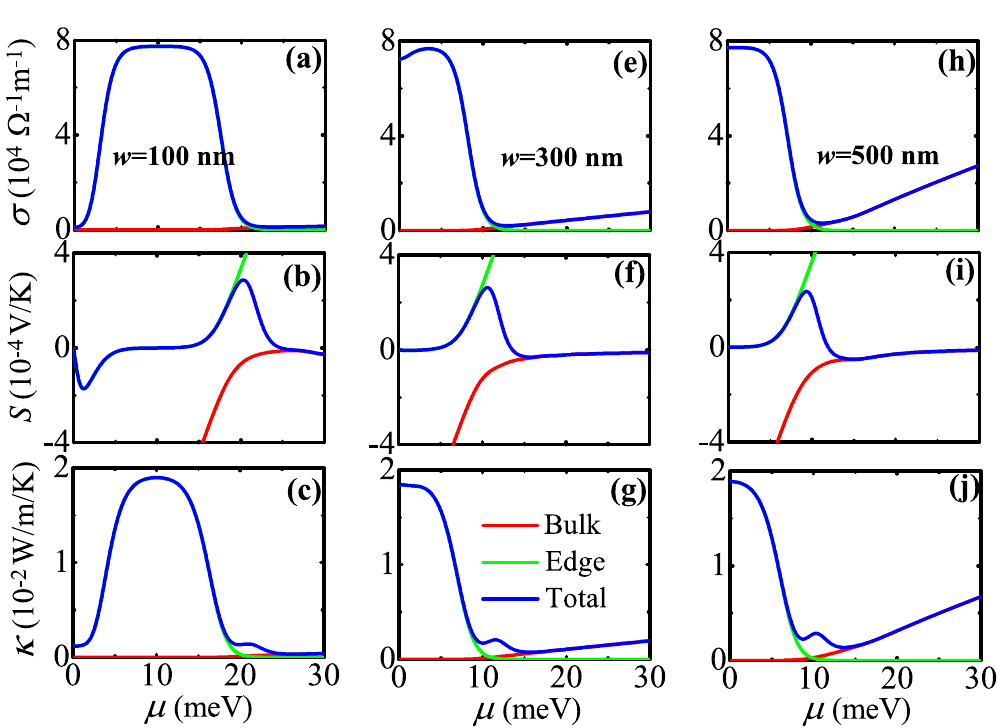
Figure 6. Electric conductivity, Seebeck coefficients, and electron thermal conductivity as a function of the chemical potential for various temperature-driven 2D TIs with different ribbon widths, where ( a )~( c ) plot the results for w = 100 nm, ( e )~( g ) for w = 300 nm, and ( h )~( j ) for w = 500 nm. Here, the black solid (dashed) line represents the edge (bulk) band-edge, the red and green solid lines represent the edge-state and bulk-state contributions to the TE transport, respectively, and the blue solid line represents the total TE transport. The temperature and QW thickness are fixed at T = 10 K and d = 7.5